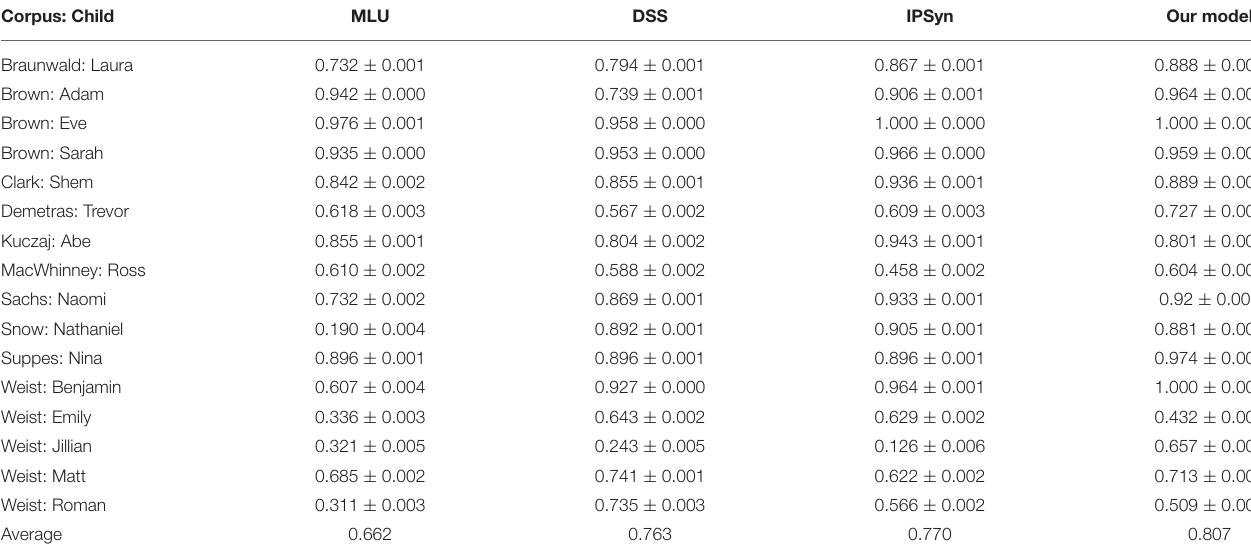
TABLE 1 | Spearman rank correlation coefficients between age in months and four language development scores for the 16 children in our dataset. Corpus: Child IPSyn Our